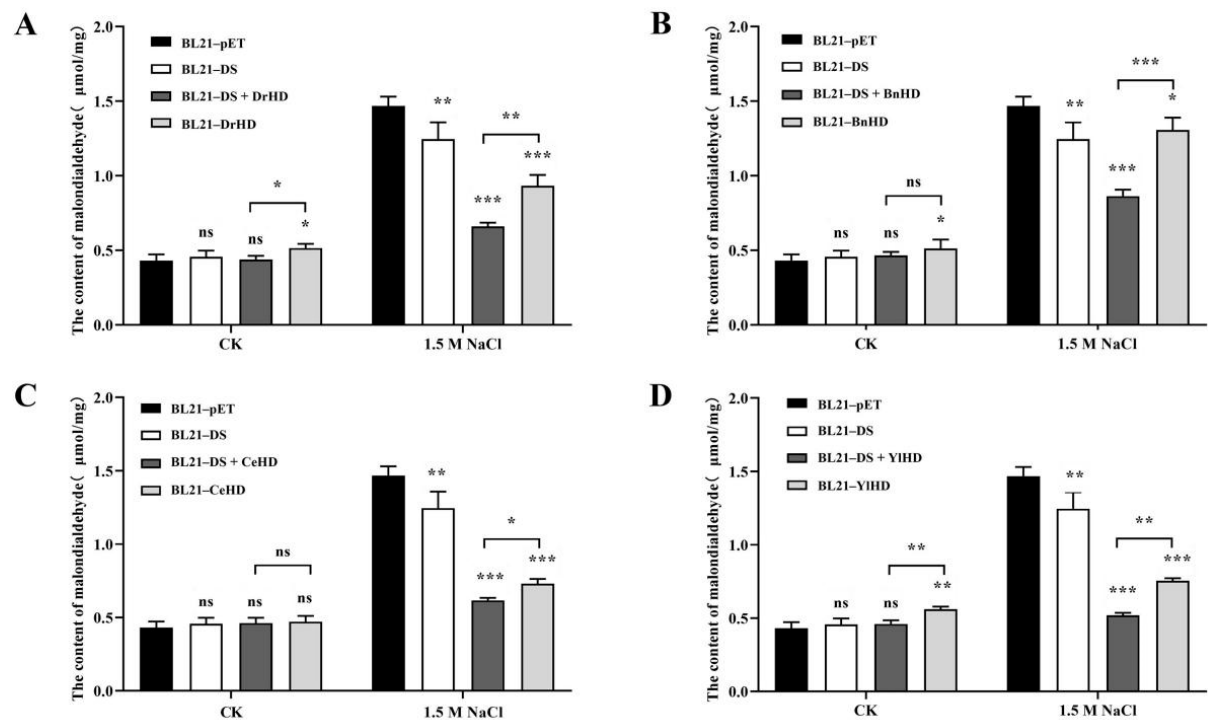
Figure 6. Analysis of MDA production. ( A ) Analysis of MDA production of recombinant strains BL21-DS + DrHD and BL21-DrHD. ( B ) Analysis of MDA production of recombinant strains BL21-DS + BnHD and BL21-BnHD. ( C ) Analysis of MDA production of recombinant strains BL21-DS + CeHD and BL21-CeHD. ( D ) Analysis of MDA production of recombinant strains BL21-DS + YlHD and BL21-YlHD. The symbols ‘ns’, ‘*’, ‘**’ and ‘***’, respectively, represent ‘no significantly different ( p > 0.05)’, ‘a significant difference (0.01 < p < 0.05)’, ‘an extremely significant difference (0.001 < p < 0.01)’, and ‘the most significant difference ( p < 0.001)’.